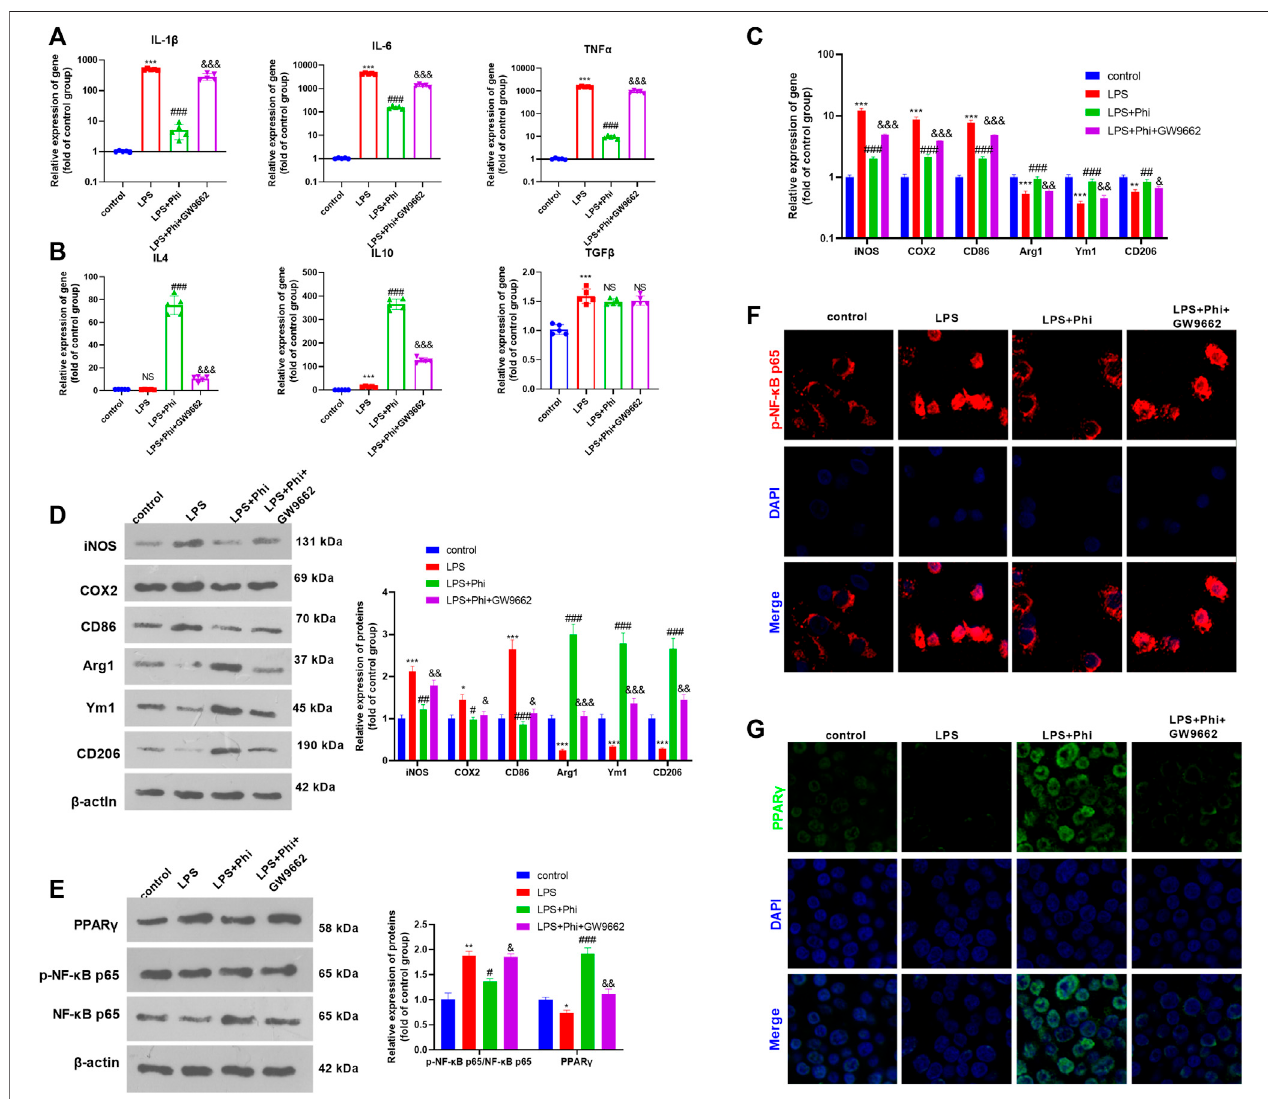
FIGURE3| Phiinhibitedthein fl ammatoryresponseofLPS-activatedmicroglia via thePPAR γ signalingpathway.ThemicrogliaweretreatedwithLPS(10 ng/ml)or phillyrin (40 μ g/ml) or GW9662(1 μ M) for 4 h. (A , B) RT-PCR was conducted to measure the “ M1 ” markers of microglia, including IL-1 β , IL-6, and TNF α , as well as “ M2 ” markers, including IL-4, IL-10, and TGF- β . (C , D) RT-PCR or Western blot was conducted to detect the mRNA or protein levels of iNOS, COX2, CD86, Arg1, Ym1, and CD206 in microglia. (E) Western blot was conducted to measure phospho-NK- κ B p65 and PPAR- γ in microglia. (F , G) Immuno fl uorescence was carried out to detectphospho-NK- κ Bp65,PPAR- γ inmicroglia.Thevaluesareexpressedasmean ± SD.NS p > 0.05,* p < 0.05,** p < 0.01,*** p < 0.001vs.thecontrolgroup;NS p > 0.05, # p < 0.05, ## p < 0.01, ### p < 0.001 vs. the LPS group; NS p > 0.05, & p < 0.05, && p < 0.01, &&& p < 0.001 vs. the LPS+Phi group. n (cid:1)